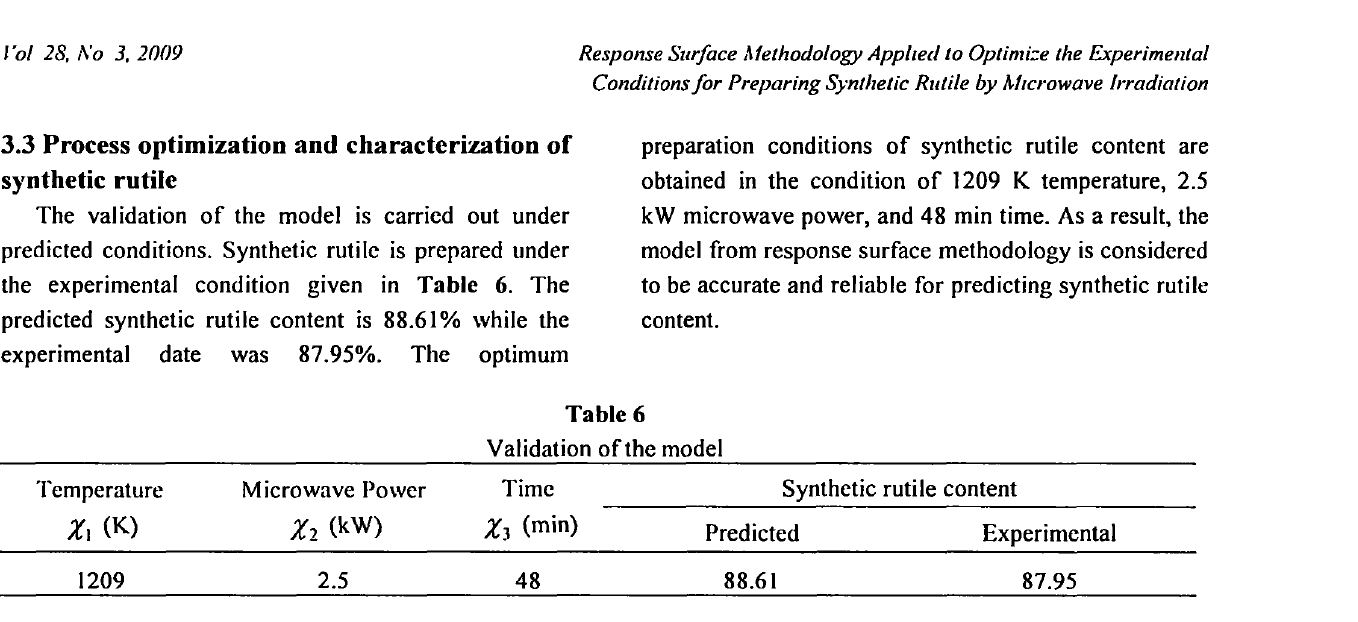
Fig. 6: XRD patterns of high titanium slag